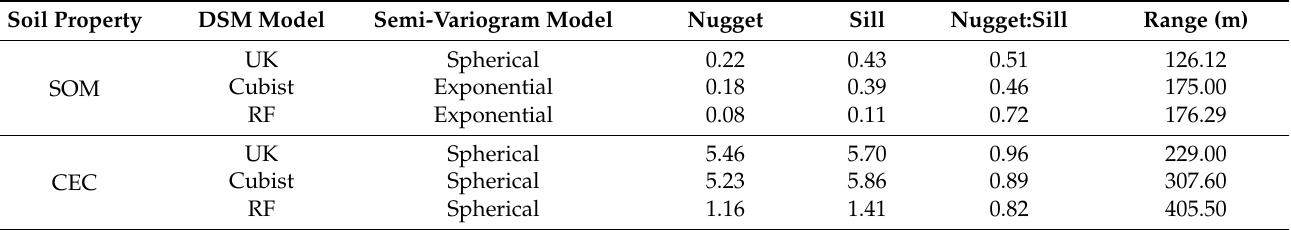
Table 4. Variogram parameters of universal kriging (UK), Cubist, and random forest (RF) model residuals to predict soil organic matter content (SOM) and cation exchange capacity